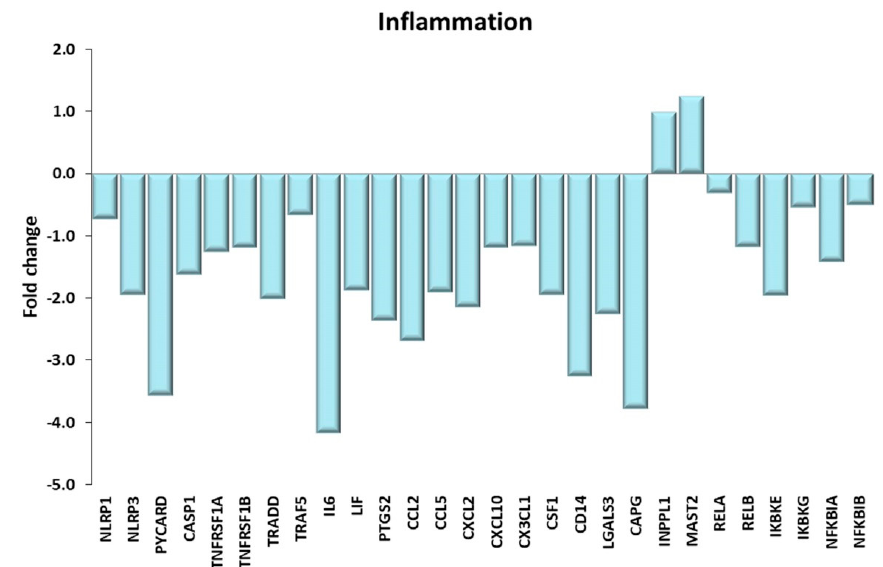
Figure 12. Inflammation. Genes discussed in the text are shown here as fold change in the comparison of TRA and SED subjects. NLRP1, NLRP3: NLR family pyrin domain containing 1, 3; PYCARD: PYD and CARD domain containing or ASC; CASP1: caspase1; TNFRSF1A, TNFRSF1B: TNF receptor